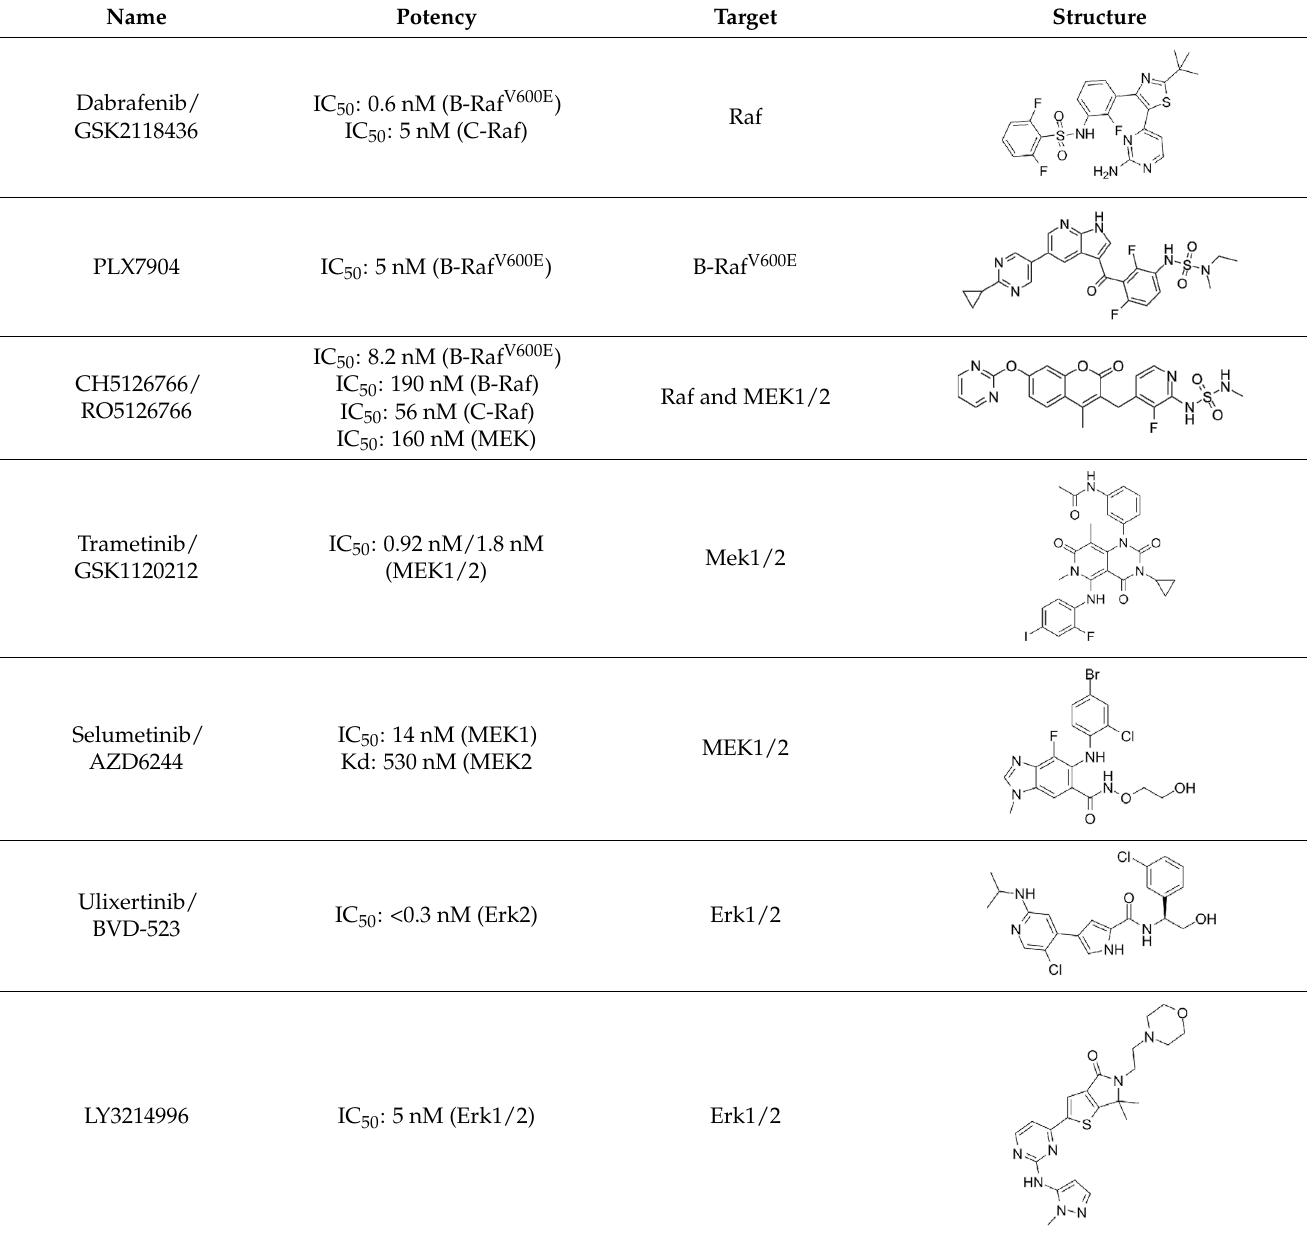
Table 1. Representative inhibitors targeting rat sarcoma virus (RAS) downstream effectors.